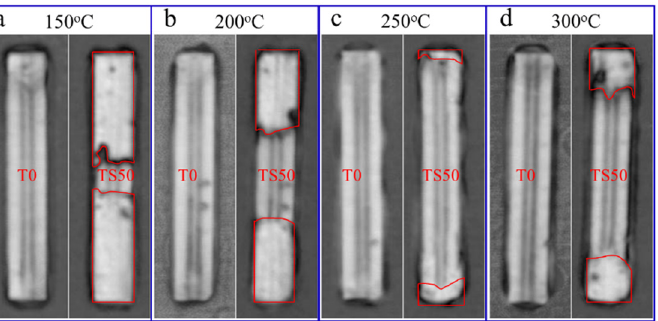
Figure 5. Comparison of the SAM images before and after the TS test at different temperatures: ( a ) 150 °C; ( b ) 200 °C; ( c ) 250 °C; ( d ) 300 °C. ( a ) 150 ◦ C; ( b ) 200 ◦ C; ( c ) 250 ◦ C; ( d ) 300 ◦